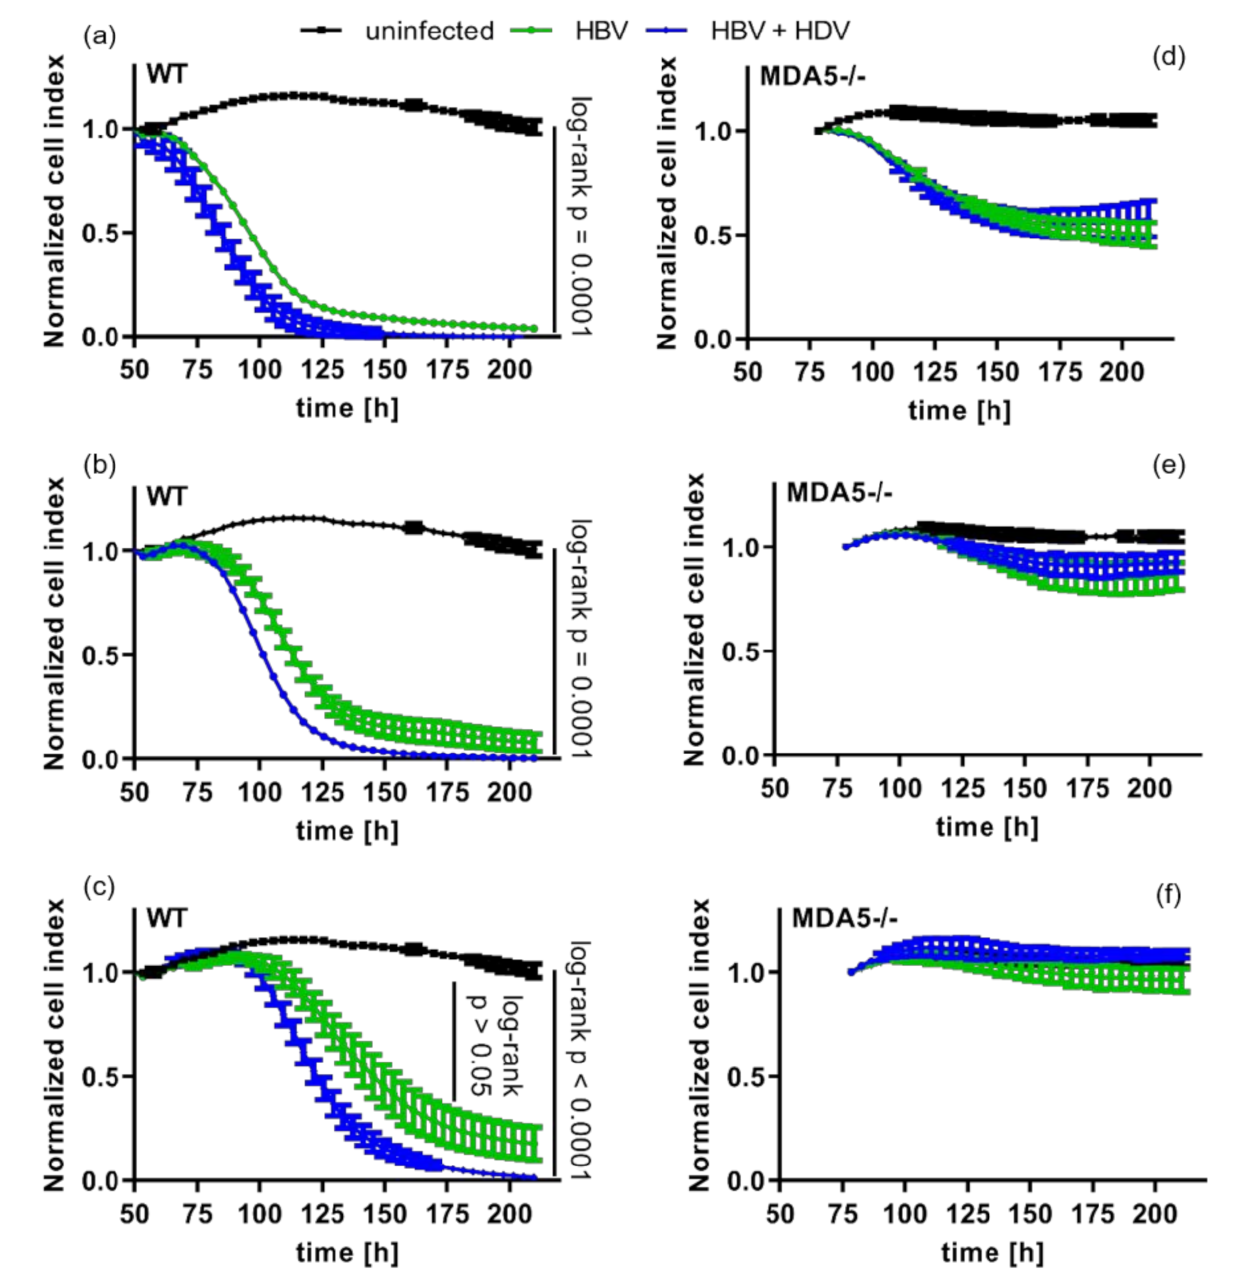
Figure 5. Pattern recognition of HDV sensitizes HBV-HDV coinfected cells to T-cell dependent cytotoxicity. Maternal and MDA5-/- HepG2-NTCP cells were infected with HBV at an MOI of 100 vp/cell and, if indicated (blue lines), coinfected with HDV at an MOI of 40 vp/cell. Cells were co-cultivated with 4G-TCR transduced T-cells at 9 dpi at an effector to target cell ratio of 1:1 ( a , d ), 1:3 ( b , e ) and 1:9 ( c , f ) and subjected to real-time cell viability assay. Graphs depict T-cell induced elimination of HBV infected cells reflected by a decreasing normalized cell index. Co-culture starts at 48 h. Graph represents a single experiment per line with biological triplicates. Statistical analysis of survival curves was done using Kaplan–Meier tests and log-rank